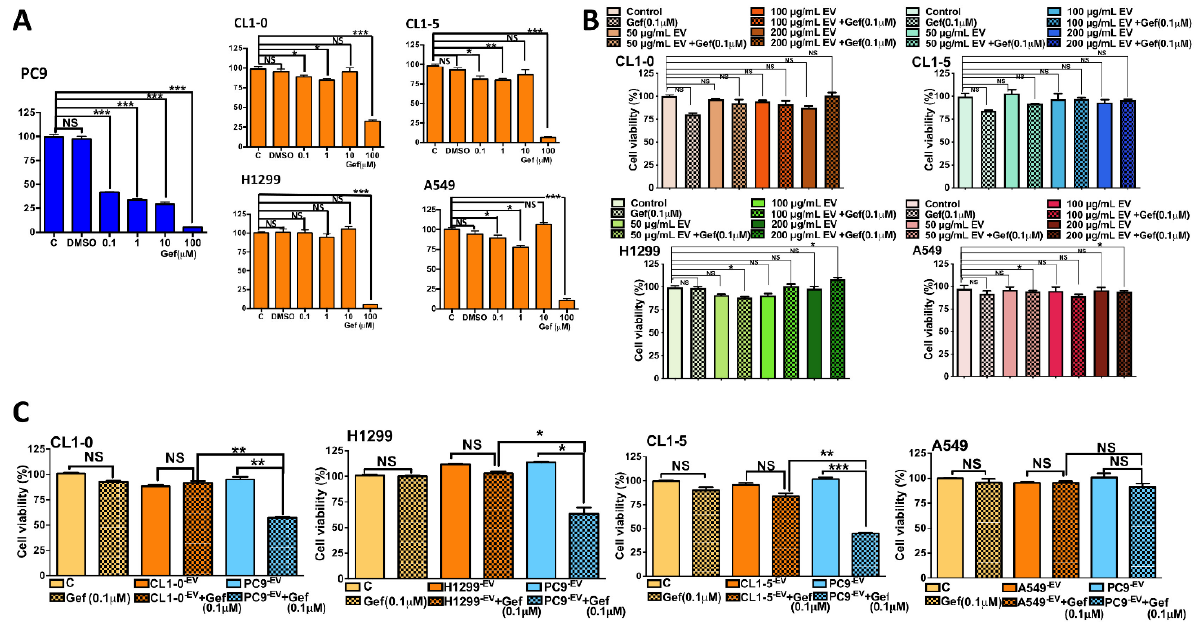
Figure 2. EVs from PC9 cells increased the sensitivity of EGFR wild-type cells to gefitinib in vitro. ( A ) MTT assay of PC9, CL1-0, CL1-5, H1299, and A549 cells in response to gefitinib. The cells were treated with gefitinib for 72 h. ( B ) CL1-0, CL1-5, H1299, and A549 cells were treated with gefitinib and titrated control EVs (200 μ g/mL) for 72 h. In addition, ( C ) CL1-0, CL1-5, H1299, and A549 cells were treated with gefitinib and EVs (200 μ g/mL) from PC9 cells or control EVs for 72 h (* p < 0.05, ** p < 0.01, and *** p < 0.005).